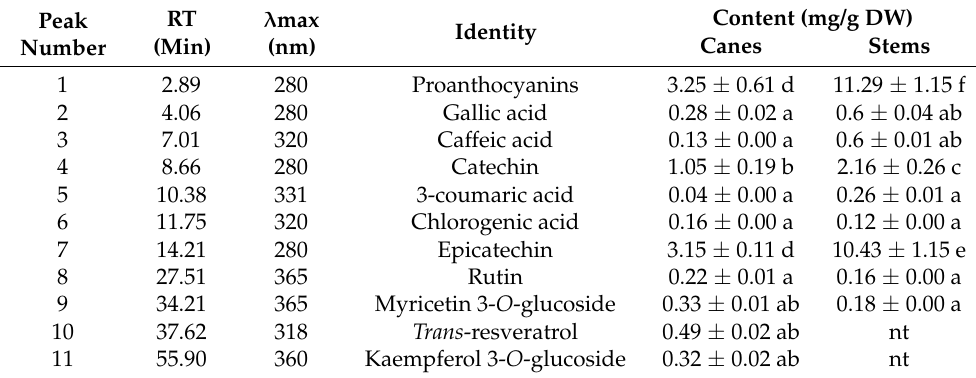
Table 1. HPLC profiles identified phenolic compounds of canes and stem extracts from V. davidii Foex based on retention